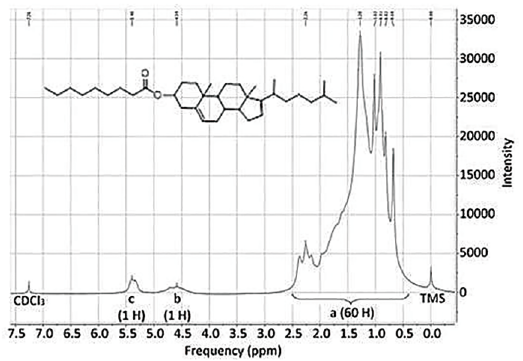
Figure 3. 1H NMR spectra for LC sample in